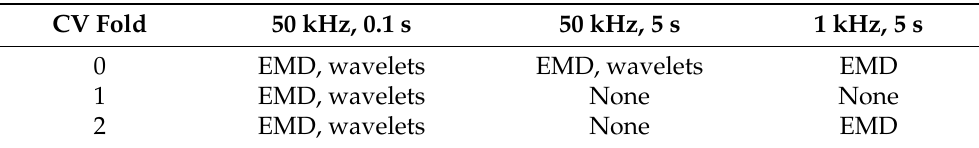
Table 4. The table shows the final order of the signal processing methods applied for all the experi- ments and cross-validation (CV) folds. The sequences are reported in the same order they are applied. ’None’ corresponds to no signal processing performed.